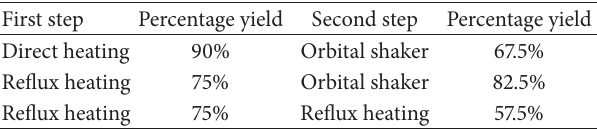
Table 1: Biodiesel yield percentage in optimum condition for dif- ferent